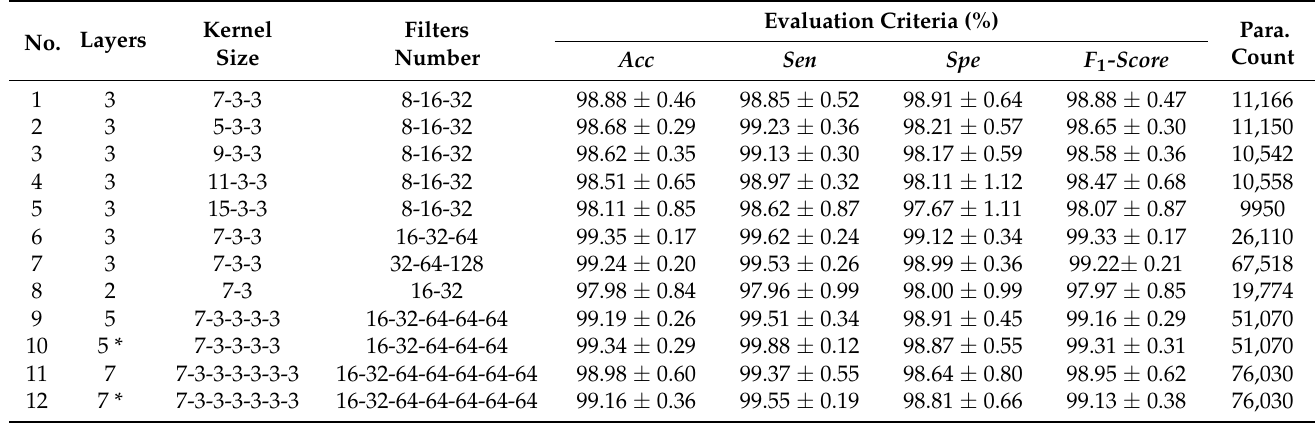
Table 4. The performance of convolutional neural networks with handcrafted features as input. These convolutional neural networks are variants of the reference model presented in Figure 5a.